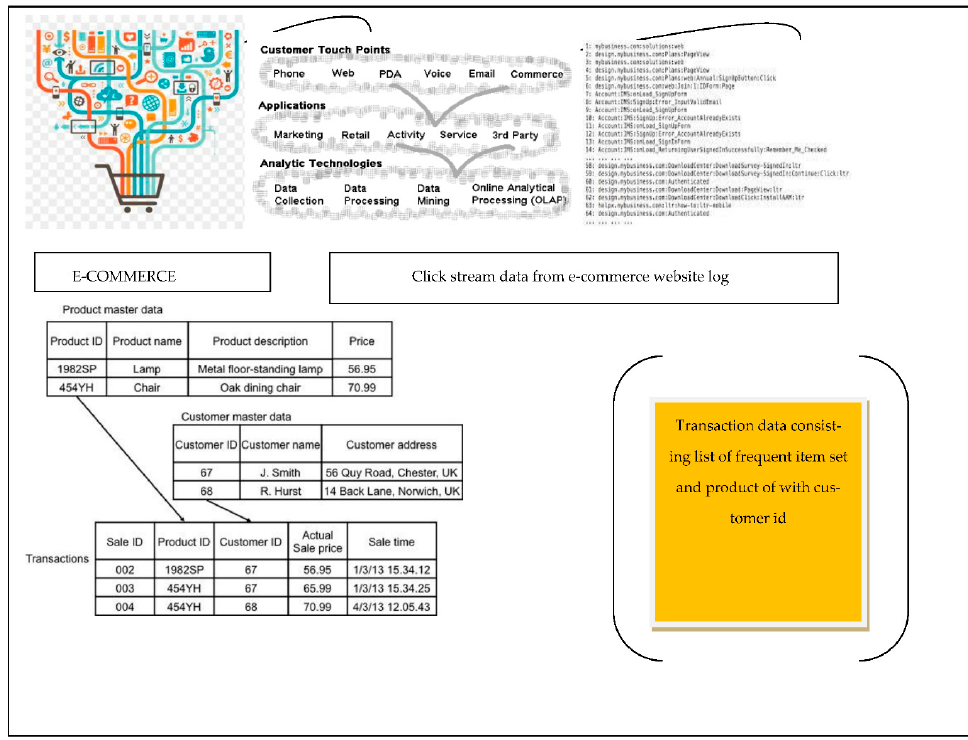
Figure 1. Overall model diagram.